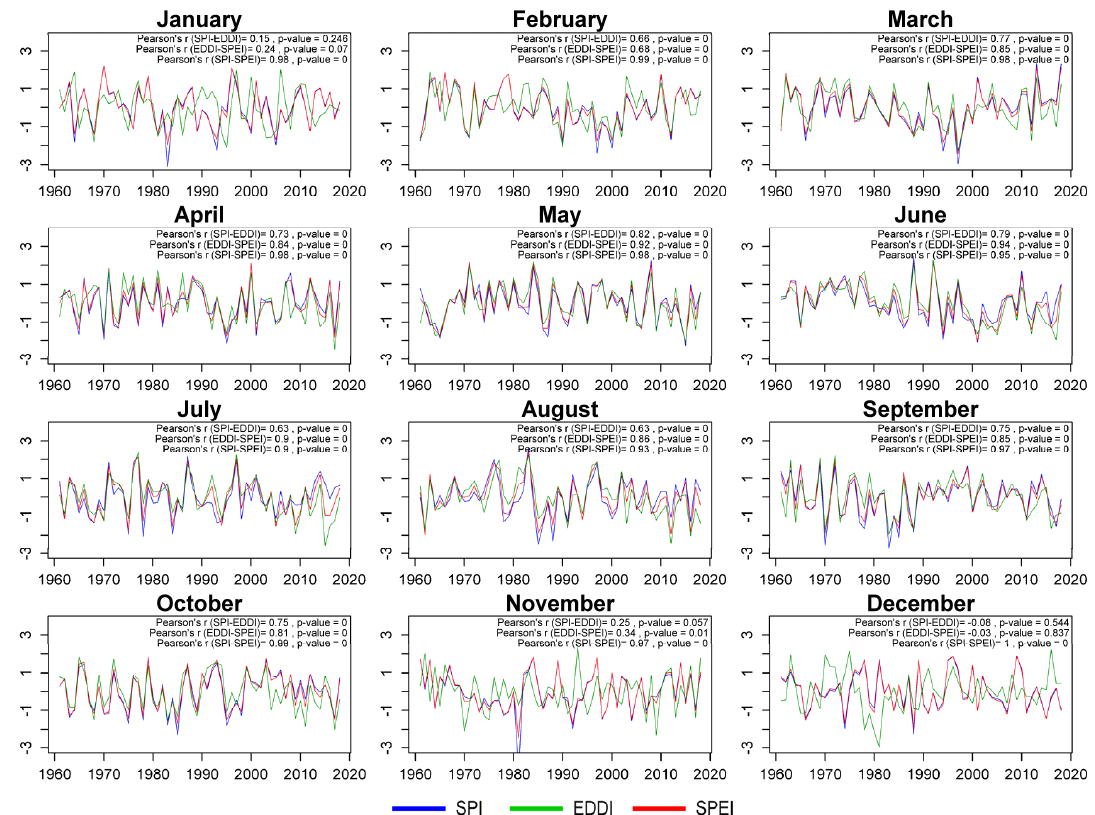
Figure 1. Temporal evolution of monthly series of the standardized precipitation index (SPI), evaporative demand drought index (EDDI), and standardized evaporation precipitation index (SPEI) based on average data on mainland Spain and the Balearic Islands over the period 1961–2018 at a short time scale (1-month). The monthly series includes the weekly data for the last week of each month in each year. Figure 2. Spatial pattern of the correlation (Pearson’s r) and associated significance between monthly series of the SPI, EDDI, and SPEI over the period 1961–2018. The monthly series include the weekly data for the last week of each month in each year.